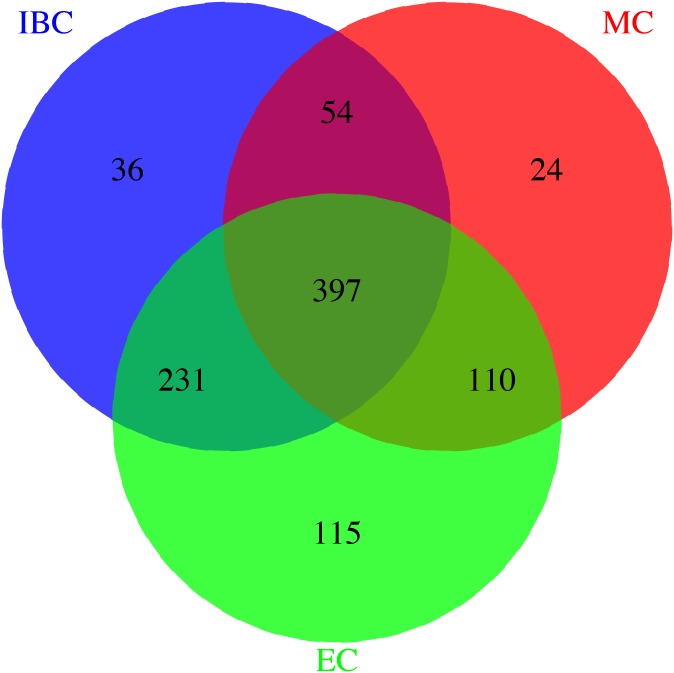
Overlap of individuals genotyped with the three platforms (after QC).